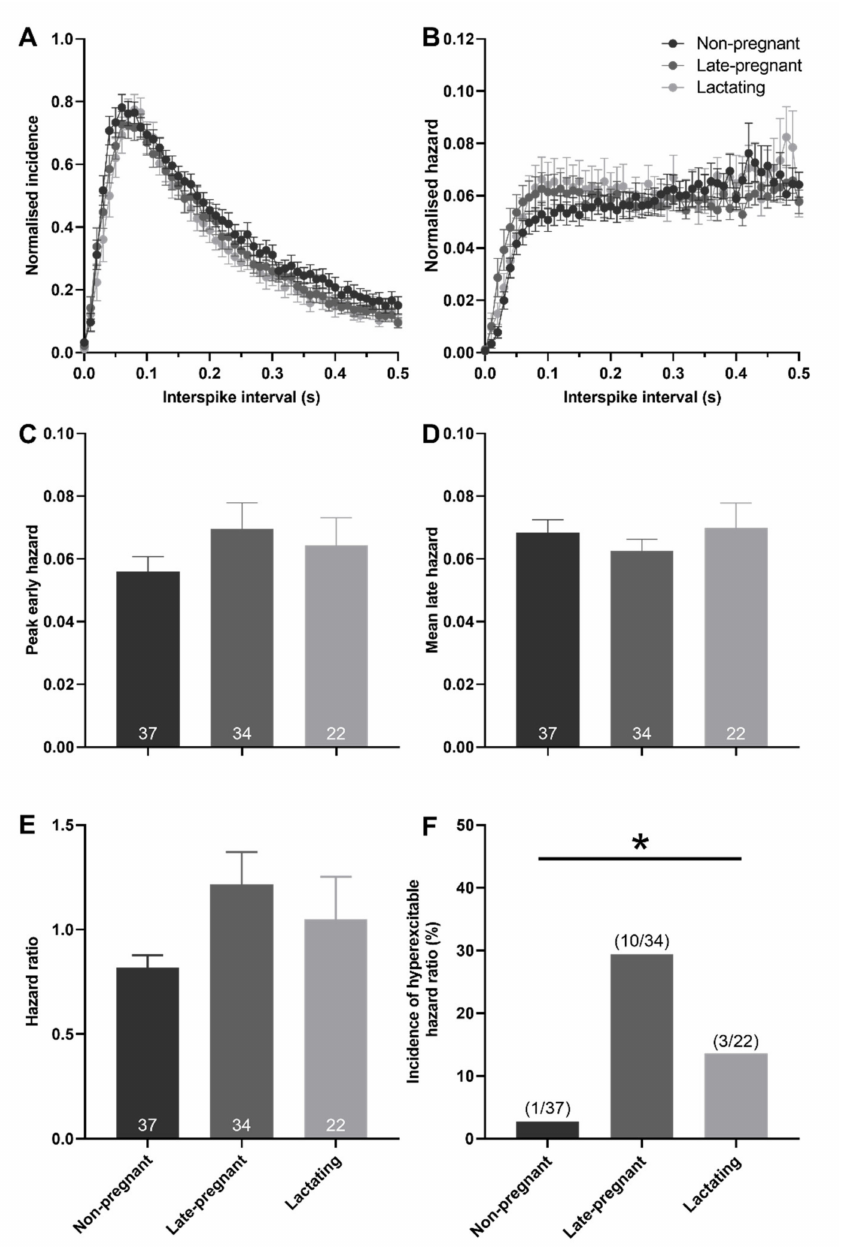
as elevated post-spike hyperexcitability in vasopressin neurons in non-pregnant, late- pregnant, and lactating rats ( χ 2 = 2.38, p = 0.30; Figure 4F).